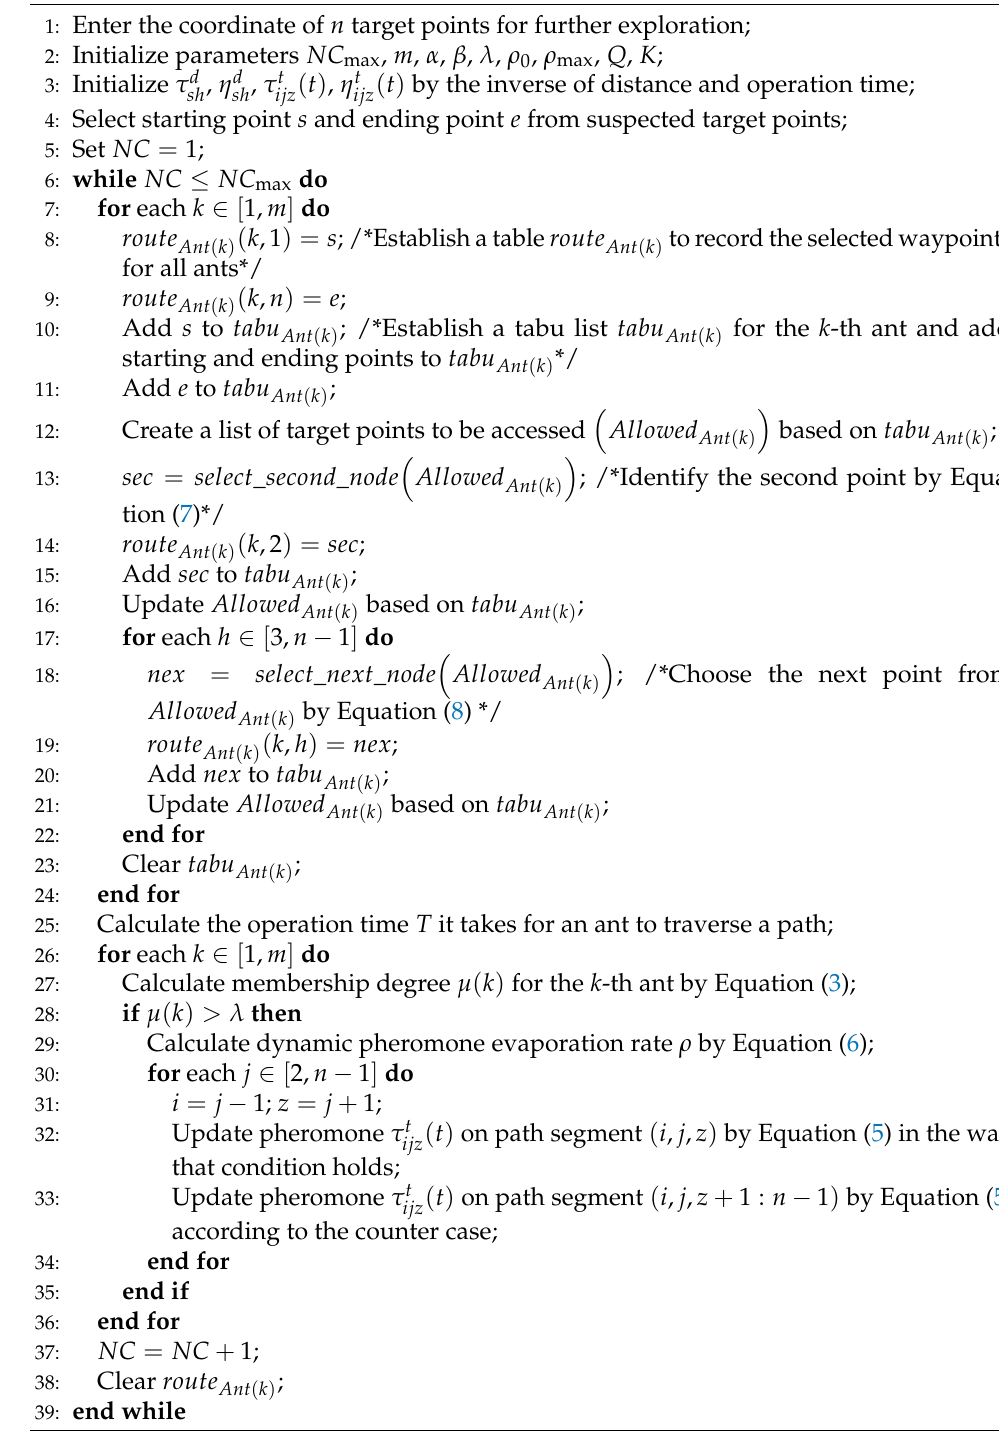
Algorithm 1 Improved ant colony